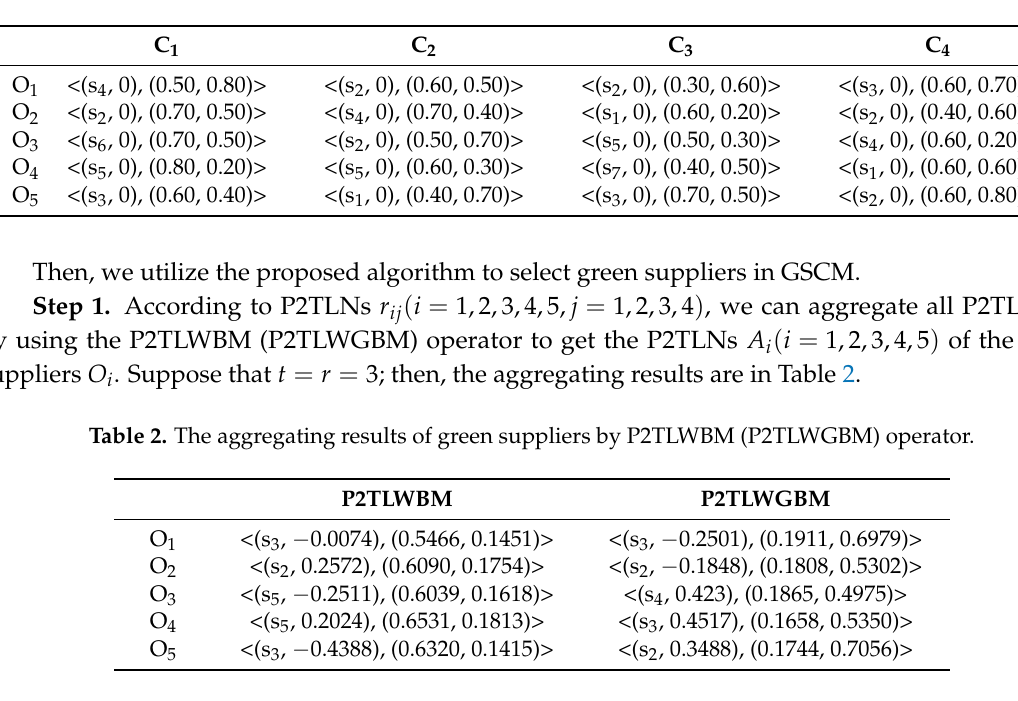
Table 1. Pythagorean 2-tuple linguistic numbers (P2TLN) decision matrix.